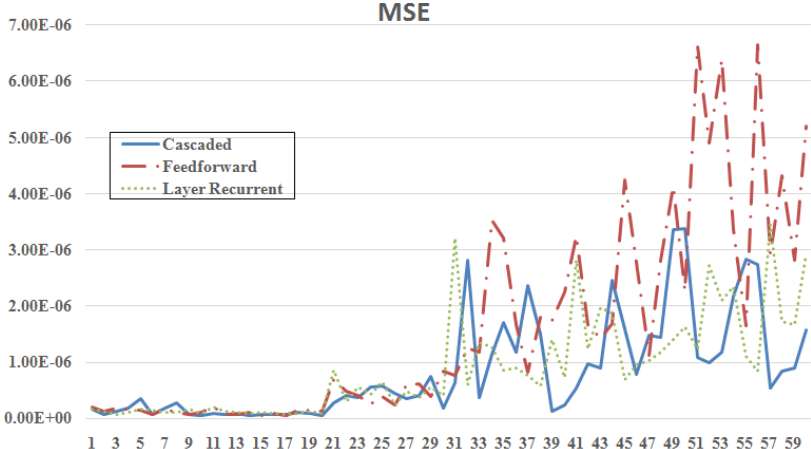
Figure 6. Mean squared error (MSE) in 60 selected models for each